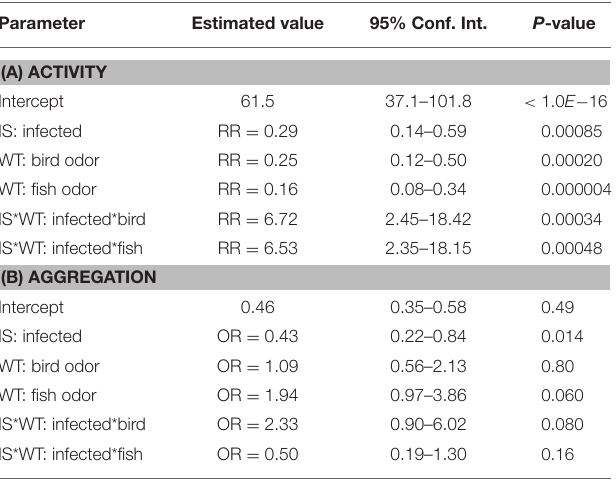
TABLE 1 | Effects of explanatory variables on activity level (relative risks) and aggregation behavior (odds ratios). Parameter Estimated value 95% Conf. Int.